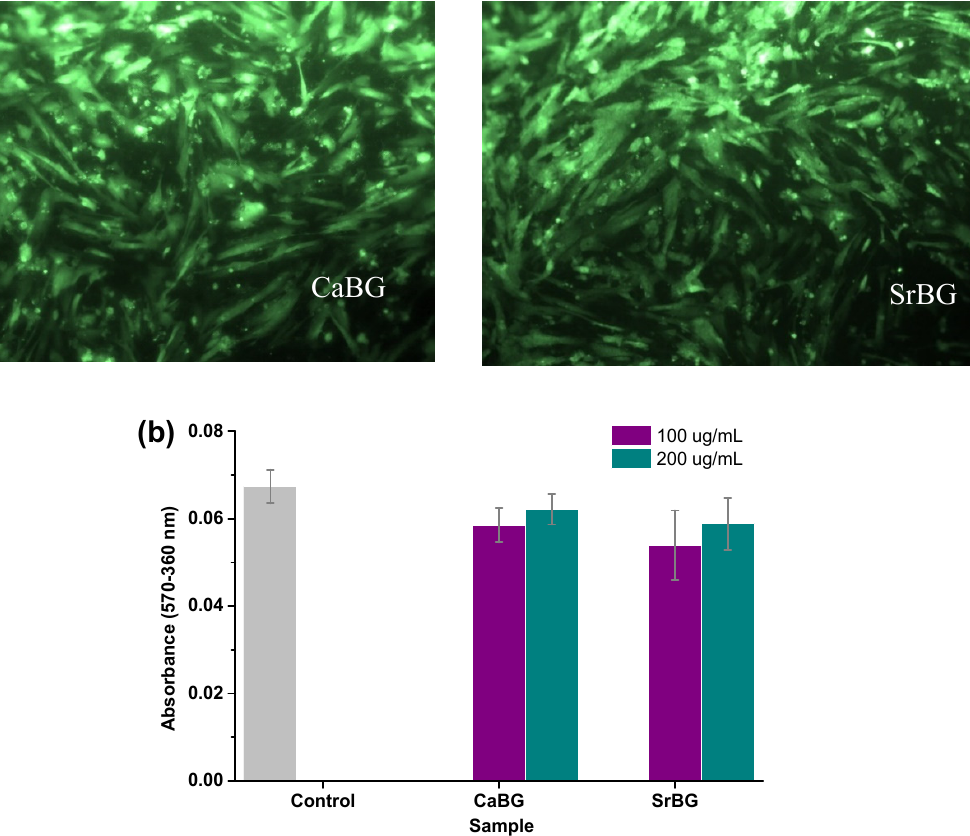
Figure 6. ( a ) Fluorescence microscopy micrographs of WJ-MSCs cells after exposure to CaBG and SrBG particles in the medium and ( b ) MTT assay results of WJ-MSCs cells after seeding for 24 h on CaBG and SrBG.